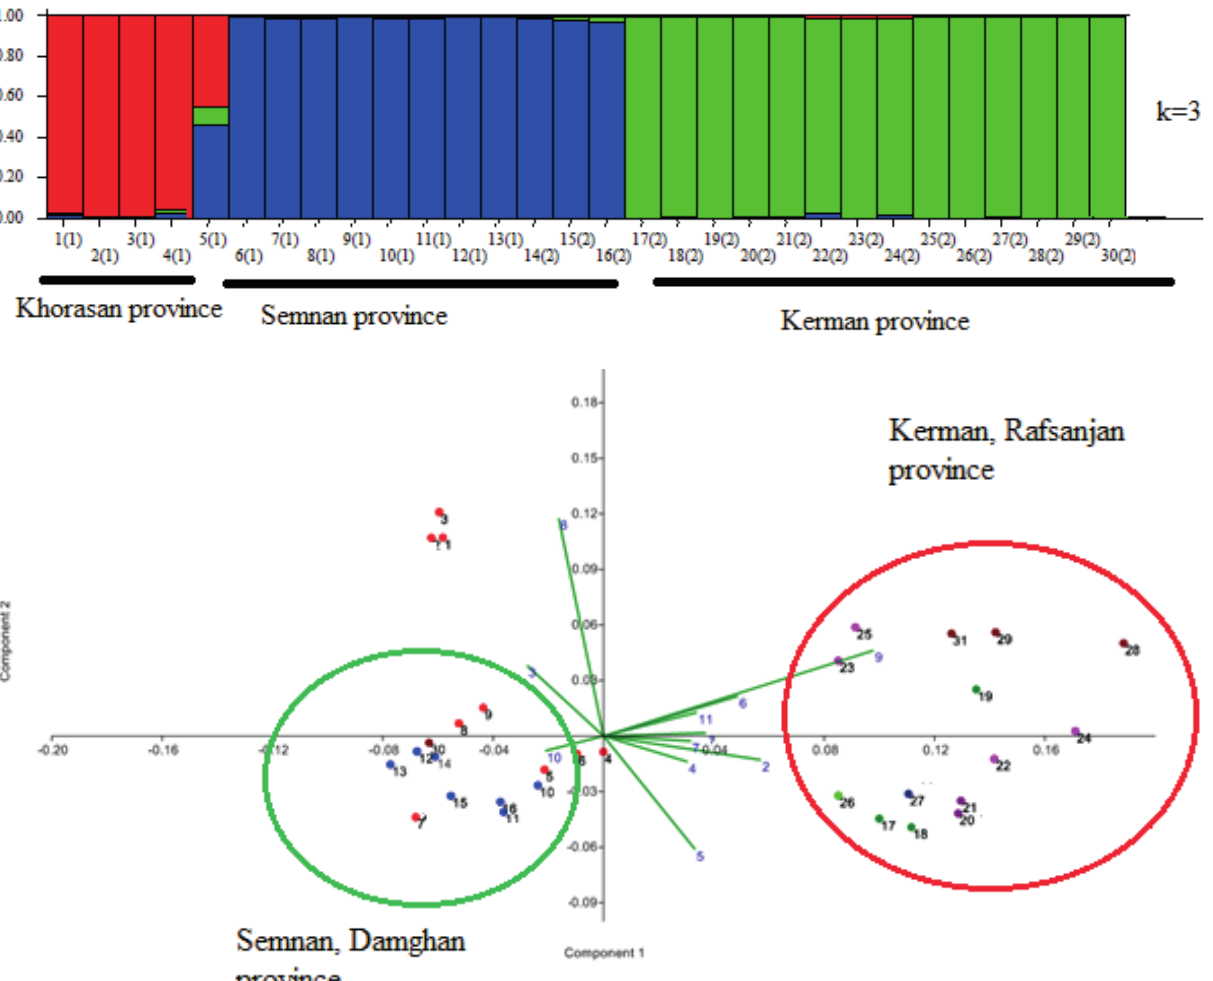
Fig. 6. Top: STRUCTURE plot of Pistacia vera populations based on k = 3, Numbers are according to Table 1.Bottom: PCA plot of Pistacia vera populations based on morphological characters. Numbers are according to Table